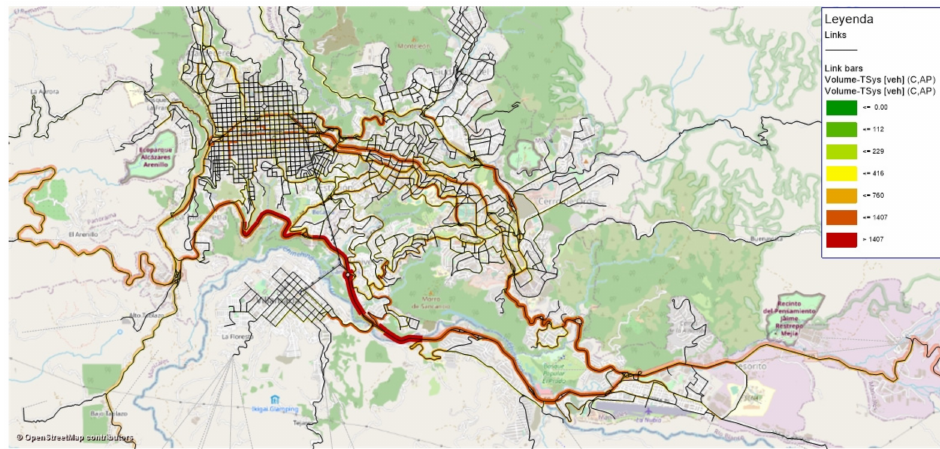
Figure 3. Volume assignment for private